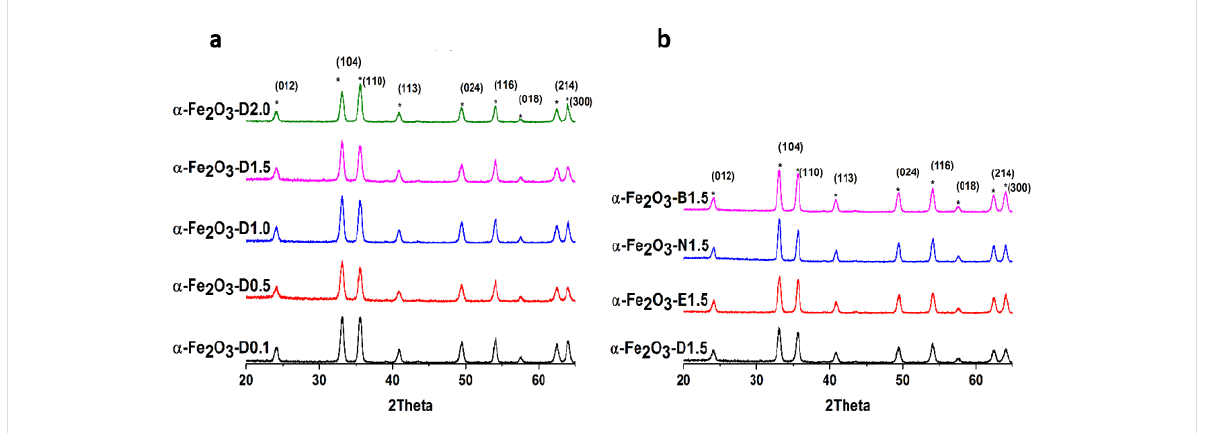
Figure 2: a) XRD patterns of α -Fe 2 O 3 nanoparticles synthesized with various Fe 3+ concentrations and 1,2-diaminopropane as the SCA and b) differ- ent diamine derivatives as SCAs and a fixed Fe 3+ concentration.